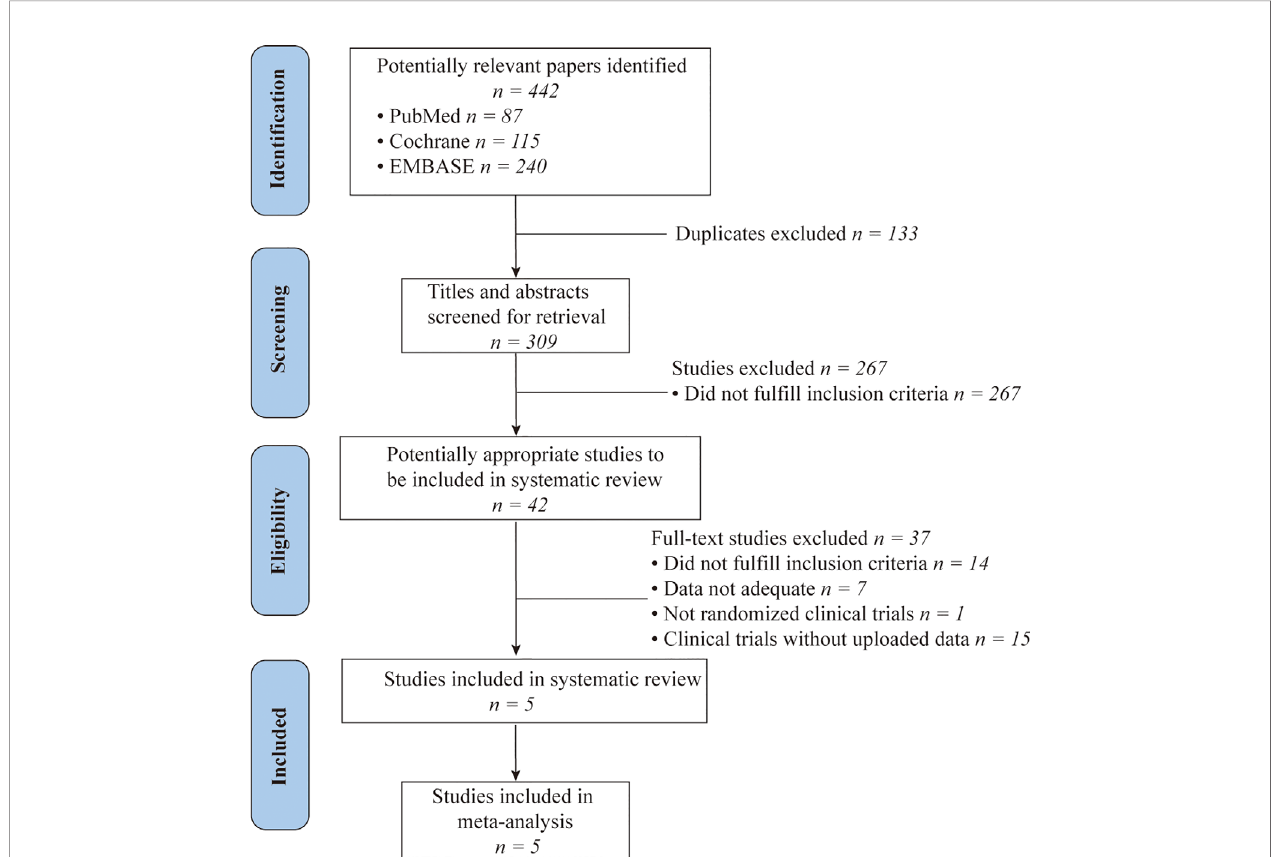
FIGURE 1 | A PRISMA Flow chart of study selection. PubMed, EMBASE and Cochrane Library databases were searched for articles published from inception to January 1,